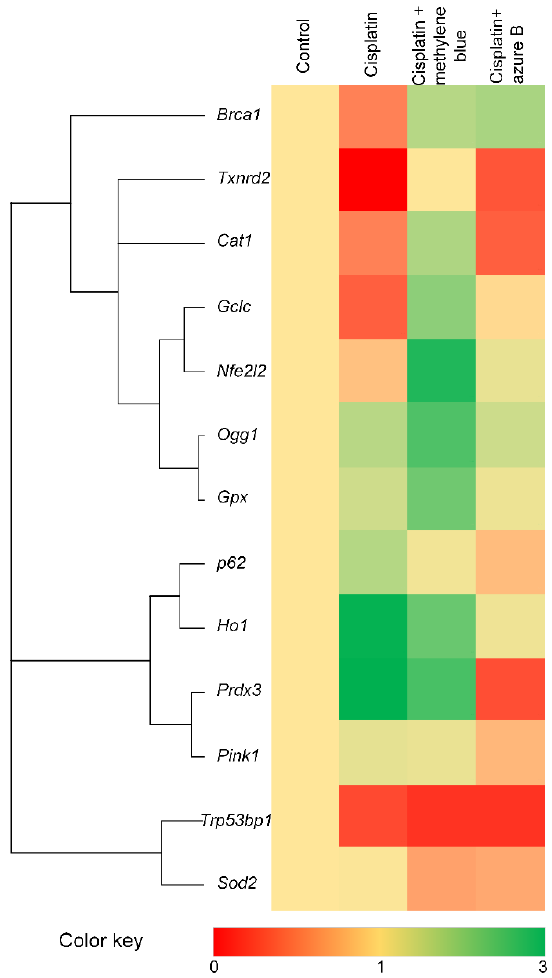
Figure 5. Heat-map of change in the gene expression in the kidneys after cisplatin injections and methylene blue and azure B treatments. Genes are grouped according to their similarity in expression profile. Control ( n = 10), cisplatin ( n = 6), cisplatin + methylene blue ( n = 8), cisplatin + azure B ( n = 8).